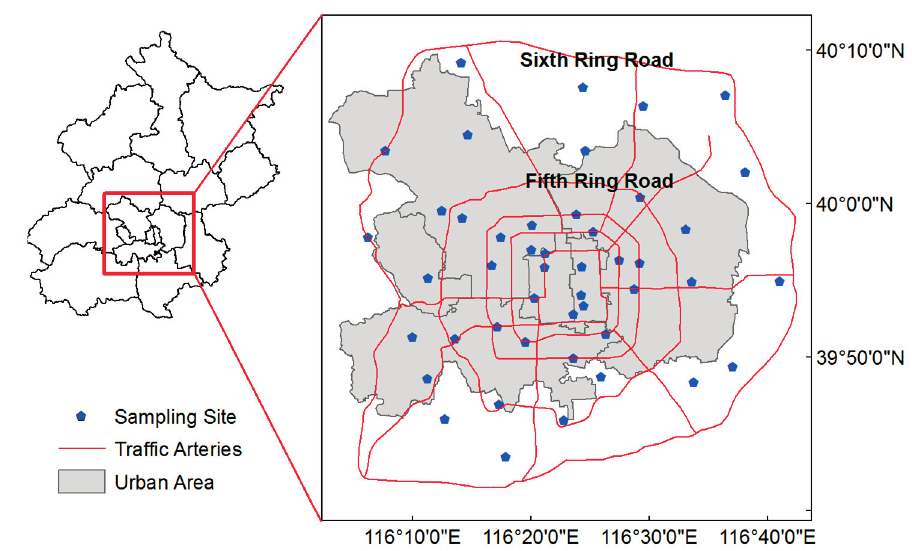
Figure 1. Location of sampling